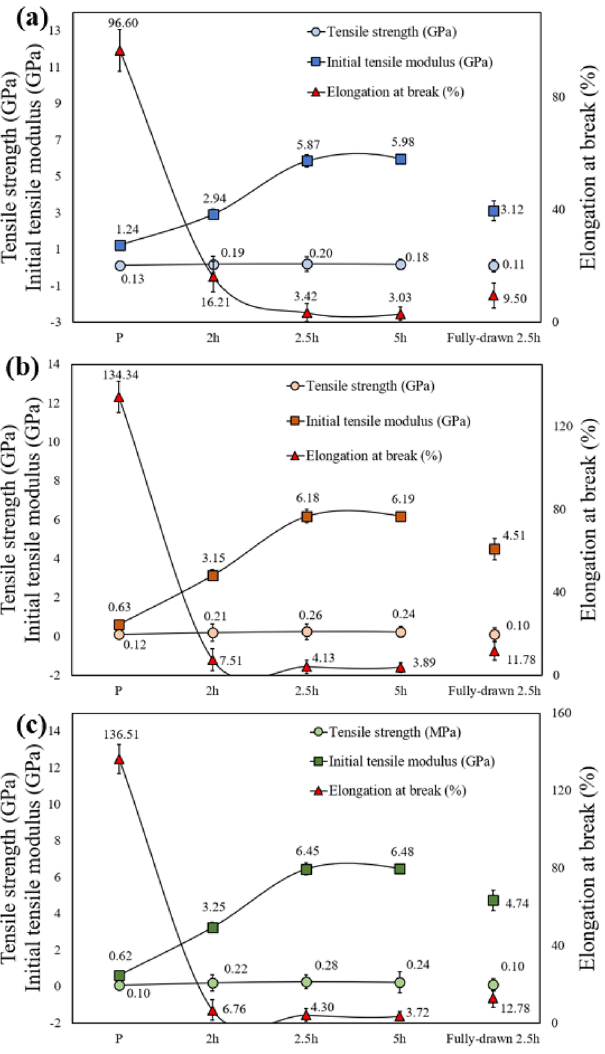
Figure 5. Tensile strength, initial tensile modulus, and elongation at break of the sulfonated LLDPE with various sulfonation time under a pressure of 5 bar and temperature of 130 °C ( a ) Sulfonated LLDPE fiber with melt flow index of 1.1, ( b ) Sulfonated LLDPE fiber with melt flow index of 10, ( c ) Sulfonated LLDPE fiber with melt flow index of